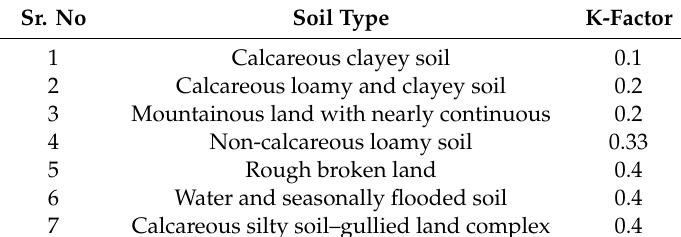
Table 2. K-factor in the Chitral